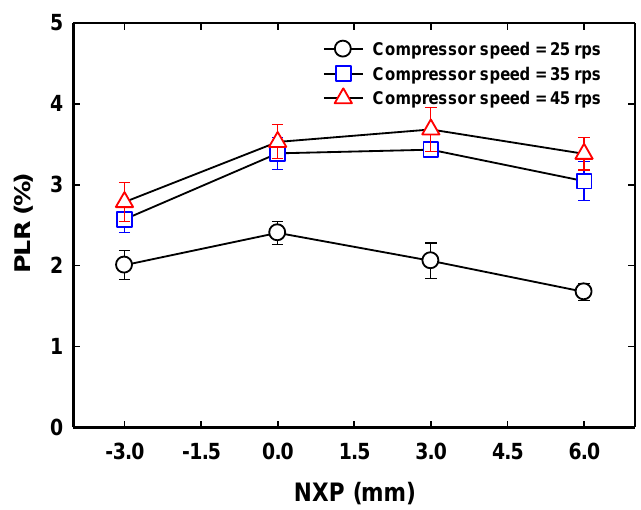
Figure 4. Variations in pressure lifting ratio (PLR) according to nozzle exit position (NXP) for variations in compressor speed at an ER of 0.3.